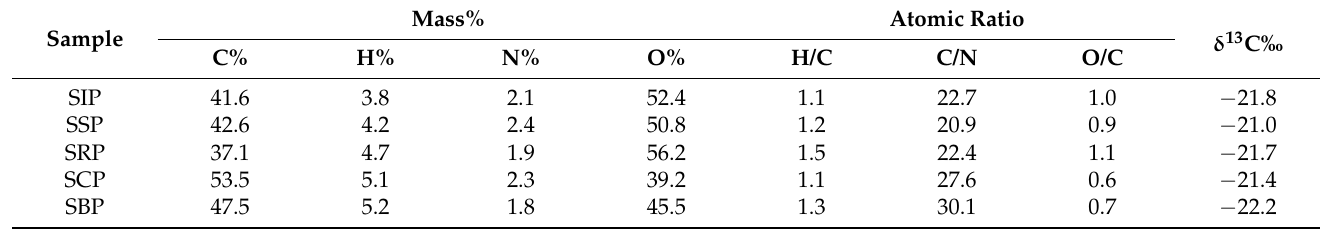
Table 2. Elemental composition, atomic ratios and stable isotopic analysis of DOM